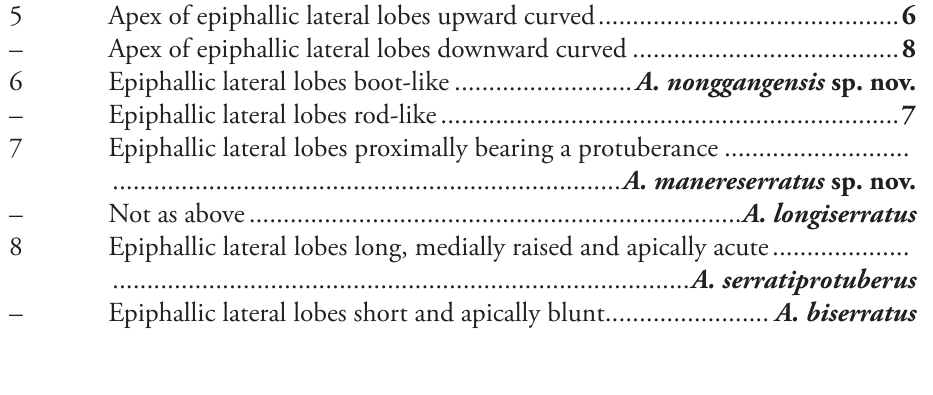
Material examined. Holotype . China: Male, Guangxi, Longzhou, Nonggang Na- tional Natural Reserve, 5.V.2019, 22.46°N, 106.96°E, Libin Ma & Tao Zhang leg.